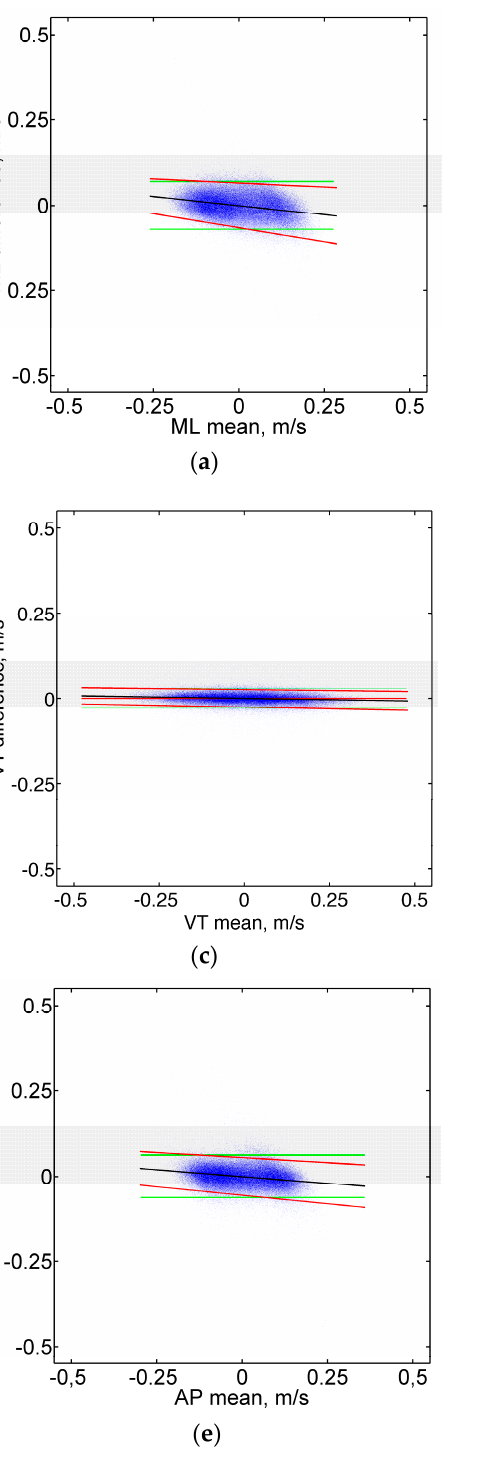
Figure 3. Bland Altman plots showing the difference between OMCS and proposed method as a function of their mean, for each component of velocity: ML ( a , b ); VT ( c , d ); and AP: ( e , f ). The plots in the panels ( a , c , e ) and ( b , d , f ) are produced from the TW and OW datasets, respectively. The line fitted to the plotted data is reported in black. The upper and lower limits of agreement based on the regression approach are reported in red. The green lines represent the constant limits of agreement computed without the regression-based correction.